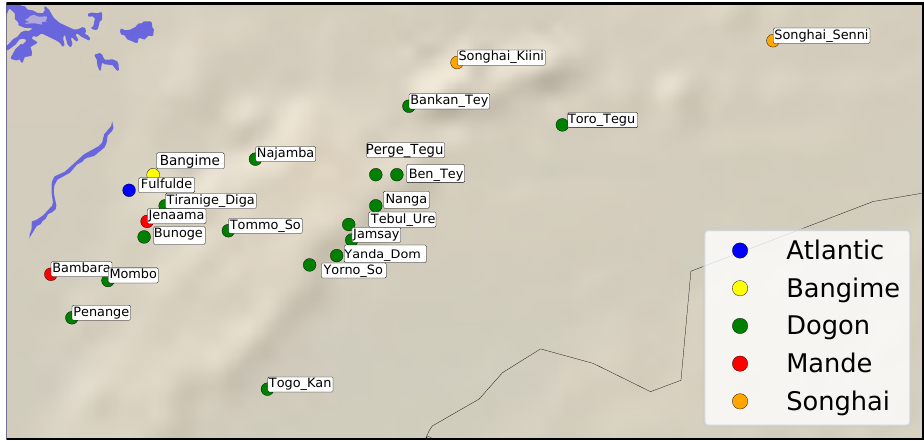
Figure 1: Bangime and its surrounding